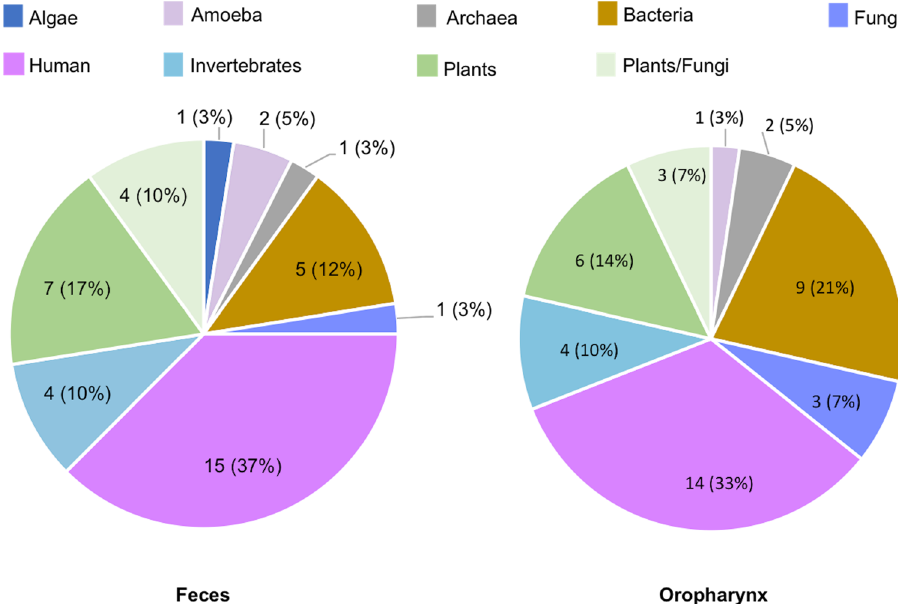
Figure 2. Hosts of the eukaryotic viral families identified in the infants’ fecal and oropharynx samples.